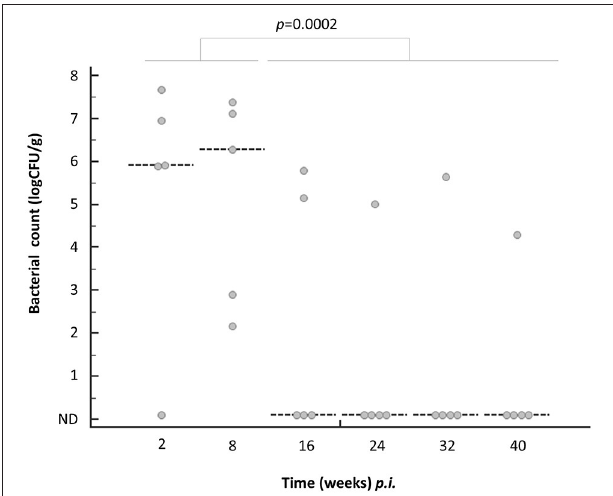
FIGURE 1 | Temporal colonization fitness of C. jejuni 81-176 in the caecum of laying hens. Each dot (gray) represents bacterial numbers detected per a gram of caecum. Dotted line represents median at each sampling time point. Statistical significance of the differences in the number of bacteria between the groups (2 and 8 weeks p.i. vs. 16–40 weeks p.i. ) by Fisher’s extract